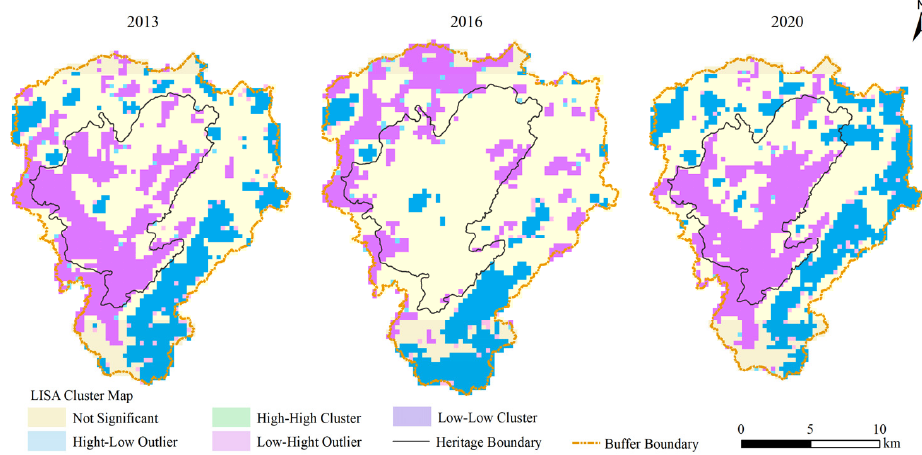
Figure 7. Distribution of spatial association types.